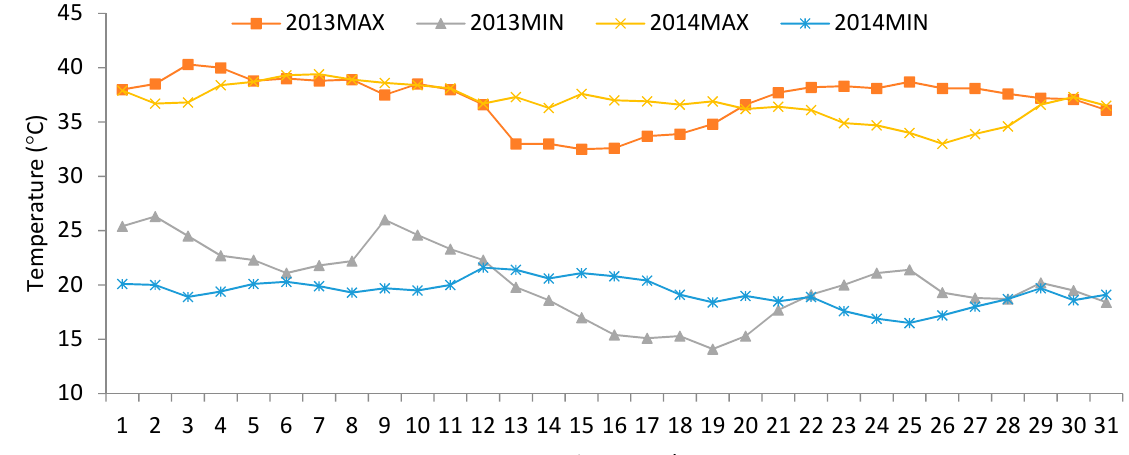
Figure 9. Daily maximum and minimum air temperatures during the flowering window in December for Chadian dry-season sorghum sown at the Youé research farms, Chad, in 2013 and 2014.